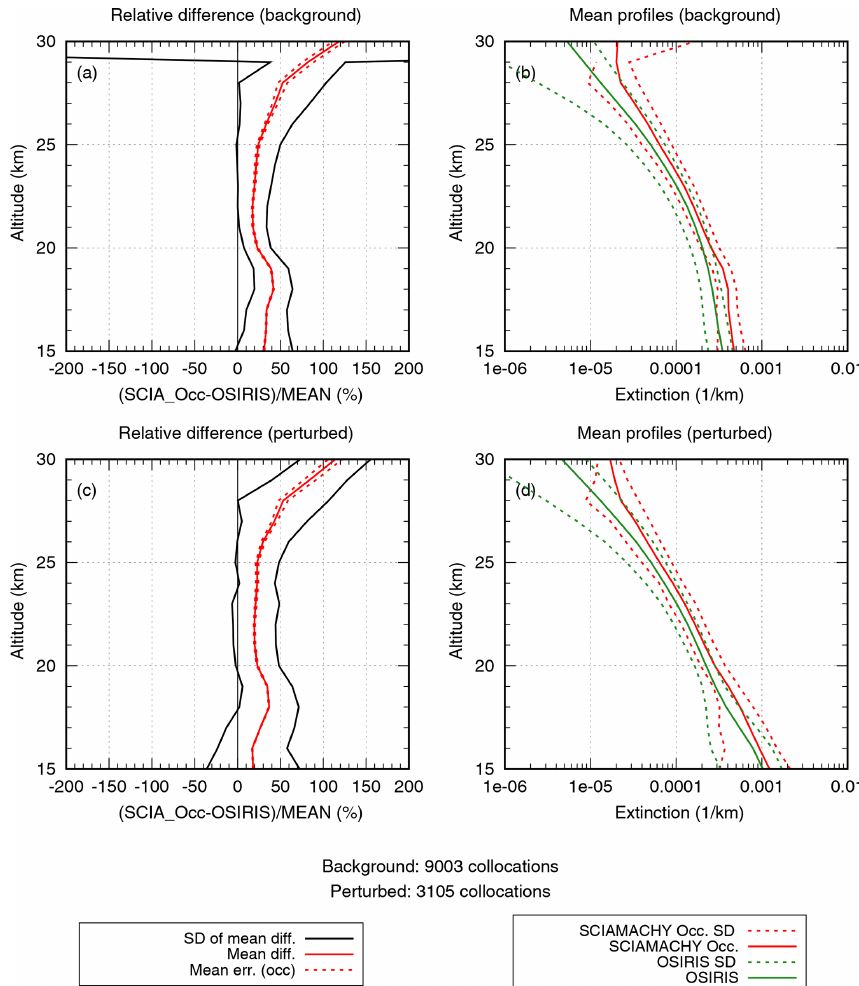
Figure 12. As Fig. 11 but for comparison with OSIRIS limb aerosol extinctions at